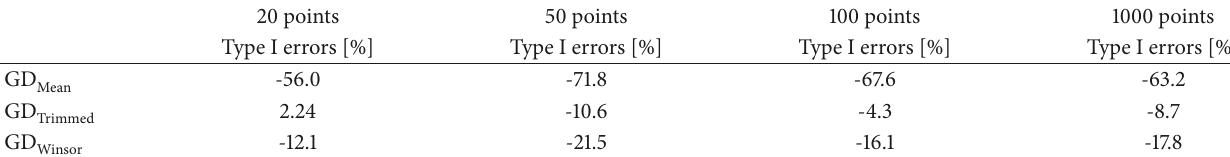
Table 7: The values of Type I errors for a log normal distribution of parameters 𝑥 = 2 and 𝑠 = 1 and 30 % of Gaussian noise. The level of noise is expressed as percentage of the mean of the distributions. In the columns we have the percentage of improvement of the Type I errors values through the GDGM methods compared to conventional methods. The distributions are composed with 20, 50, 100, and 1000 points. The minus sign indicates an improvement with respect to the corresponding technique calculated without the GDGM.